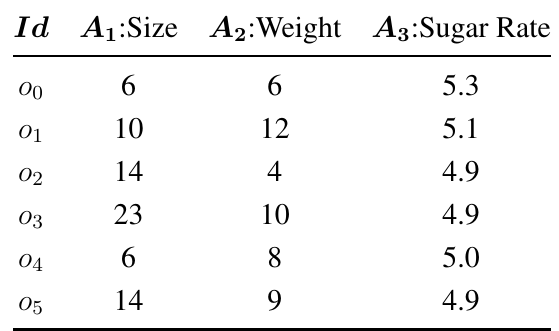
Table 1. Example of a database of some fruit characteristics: size, weight, and sugar